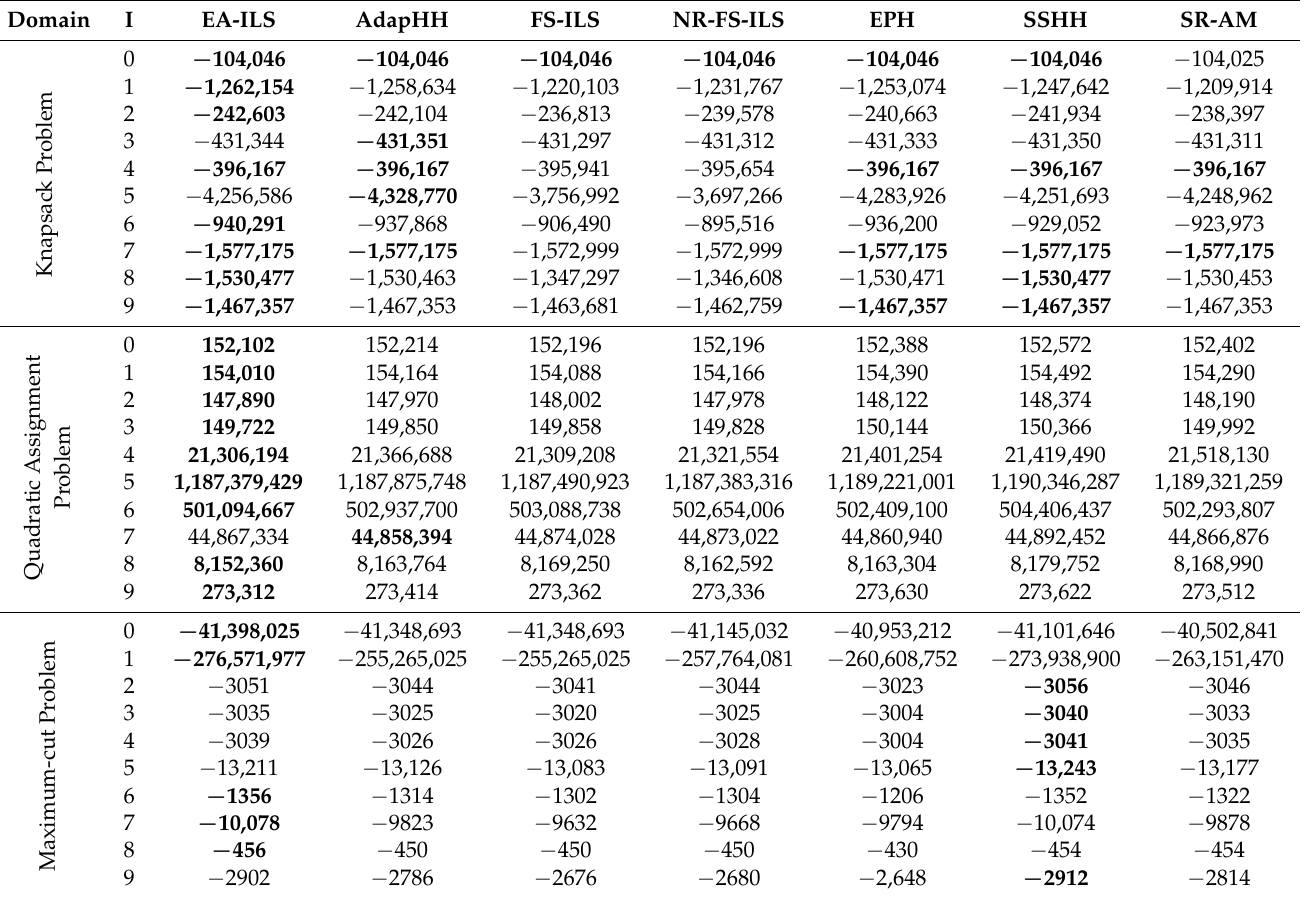
Table 4. Median ofvs Obtained by the EA-ILS in Comparison to the Existing